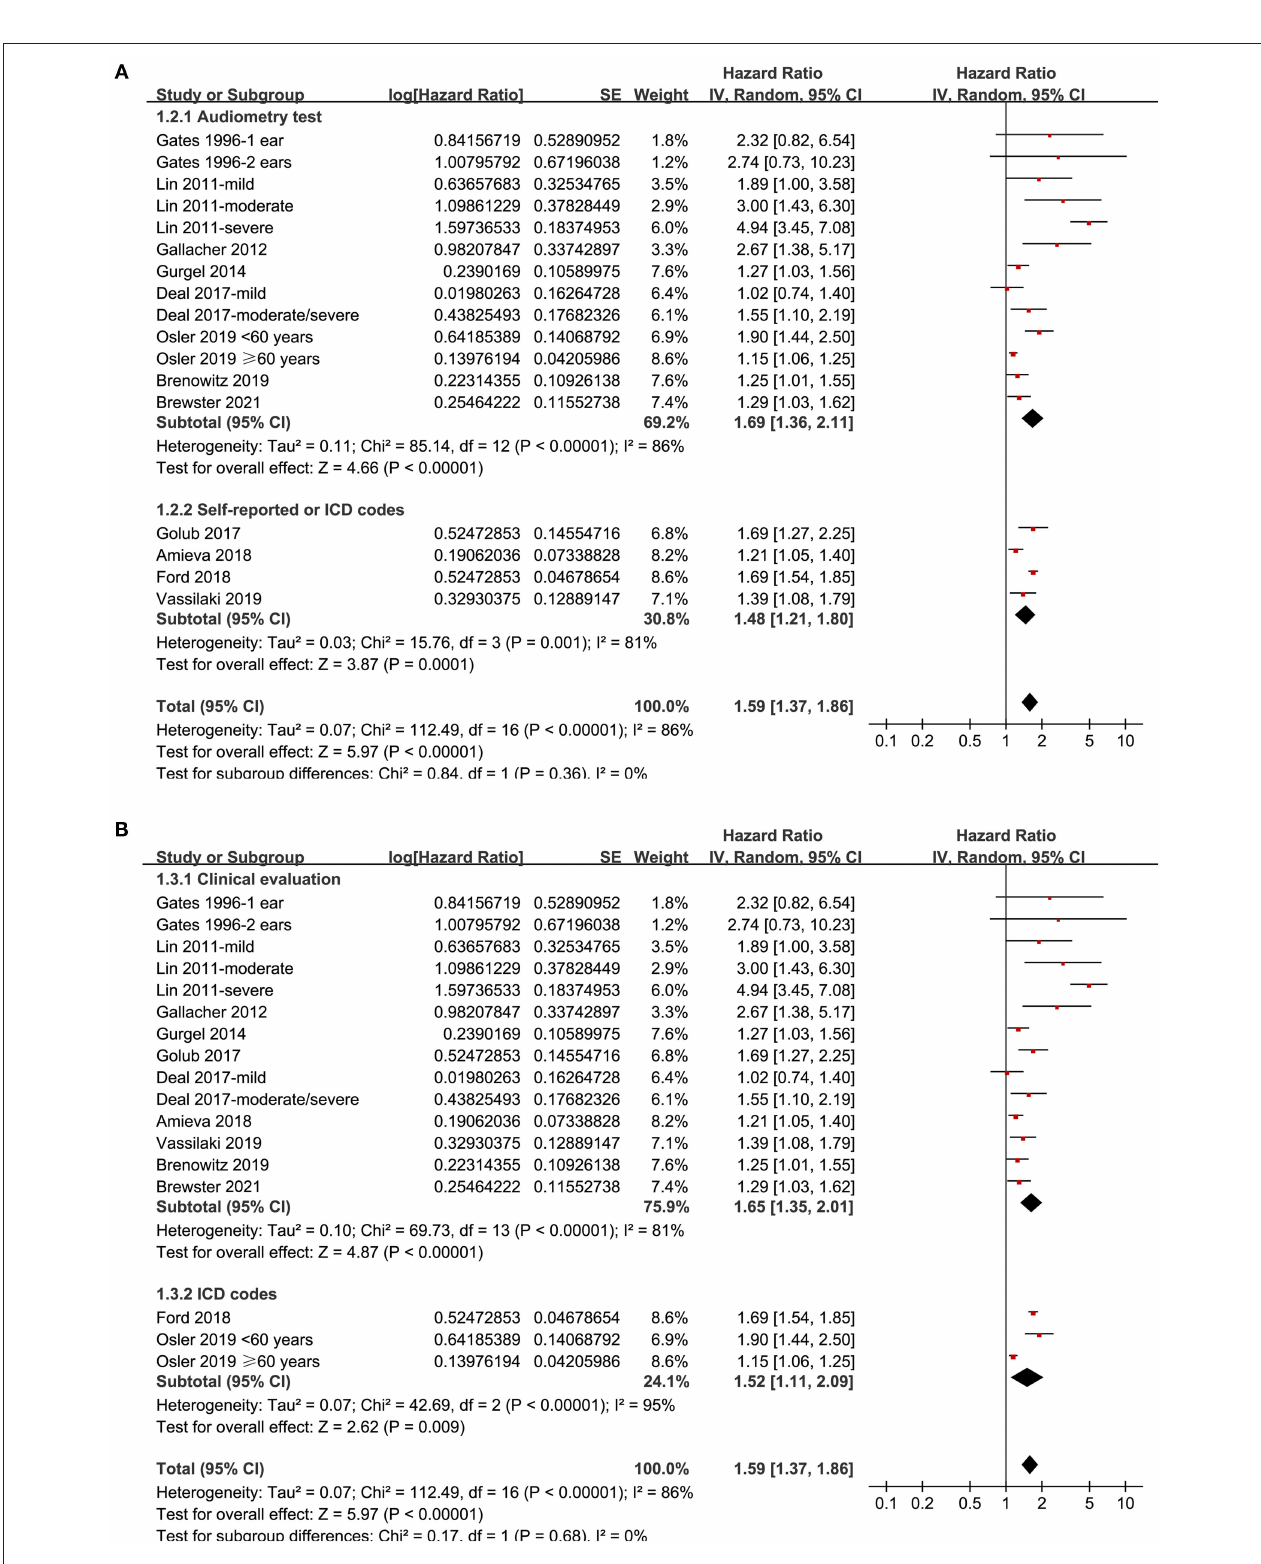
FIGURE 3 | Subgroup analyses for the outcome of all-cause dementia. (A) Subgroup analysis according to the diagnostic methods for hearing loss, and (B) subgroup analysis according to the validation strategy for dementia.